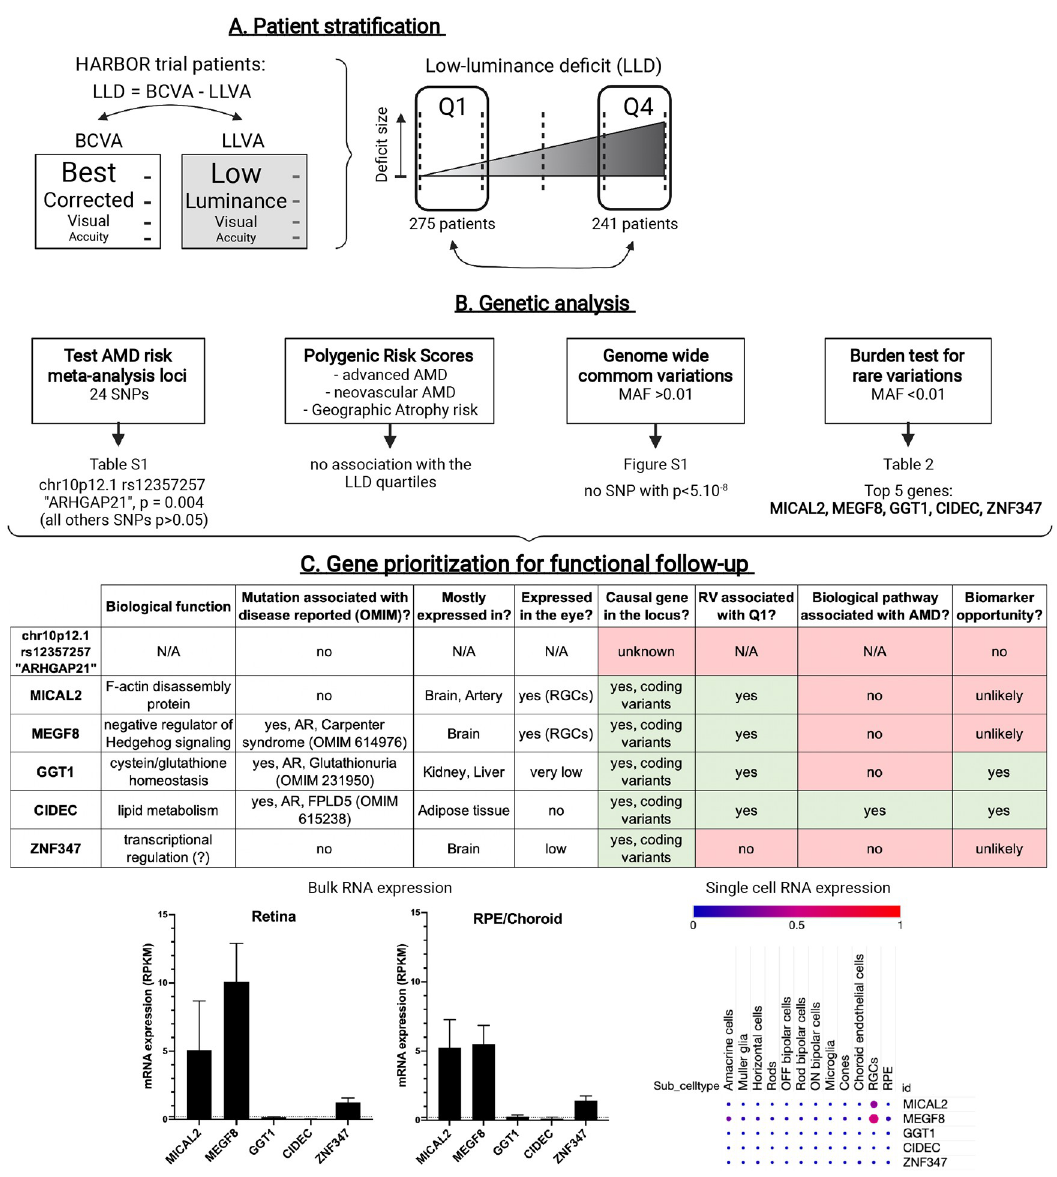
Fig 1. Overview of the patient stratification, the lines of genetic investigation performed and the strategy used to prioritize genes for functional follow-up. (A). HARBOR patients were separated at baseline into two groups based on the size of their Low- Luminance Deficit (LLD): patients in quartile 1 (Q1) had the smallest drop in vision under low-luminance and patients in quartile 4 (Q4) had the biggest deficit. (B). Lines of genetic investigation and top-line results. (C) For functional analysis follow-up, top genetic hits were prioritized based on different criteria such as being the causal gene at the locus (presence of coding variants), the rare variants (RV) identified being enriched in Q1 patients, the gene playing a role in a biological pathway associated with AMD pathophysiology, and providing a potential biomarker opportunity. For the top hits, gene expression in human retina or RPE/ choroid (bulk RNA sequencing, data from Orozco et al. [17]) and in different human ocular cell types (single cell RNA sequencing, data from Gautam et al. [18]) were also analyzed. AR: autosomal recessive; FPLD5: Familial Partial Lipodystrophy type 5. RGCs: Retinal Ganglion Cells. RPE: Retinal Pigment Epithelium.